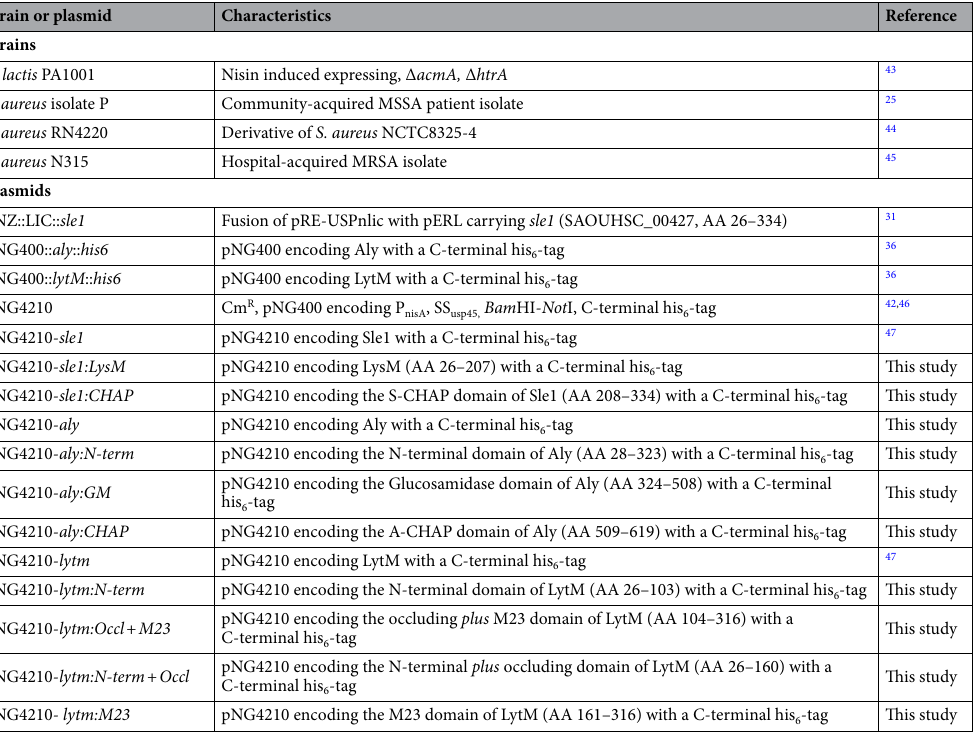
Table 1. Strains and plasmid used in this study. Cm R chloramphenicol resistance gene, P nisA nisin-inducible promoter, His 6 hexa-histidine-tag, SS usp45 signal sequence of usp45 , AA amino acid residues.